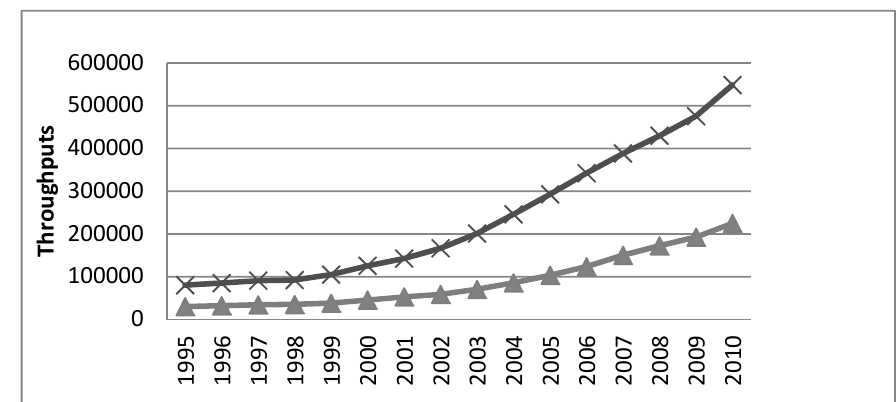
Throughput of the selected 9 ports Total Throughput of the Source: China statistic year book and China shipping year book